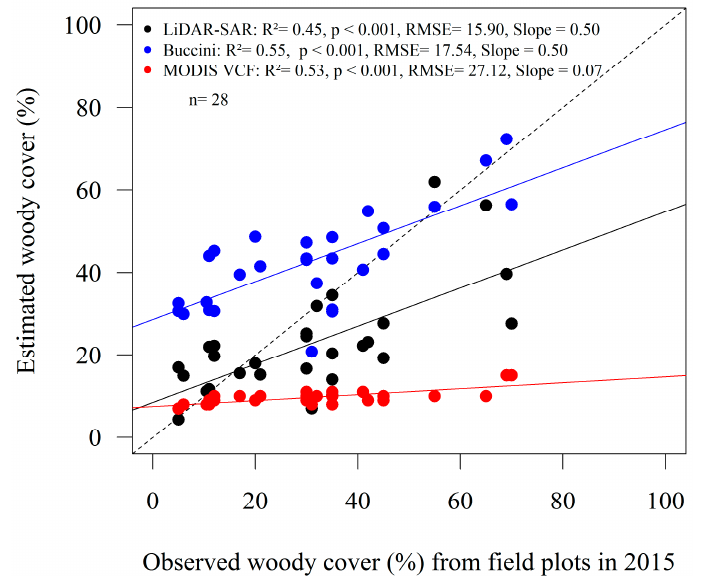
Figure 6. Validation of woody cover estimated from MODIS VCF, LiDAR/SAR, Bucini woody cover estimates (2001) observed woody cover from the field plot data 2015.